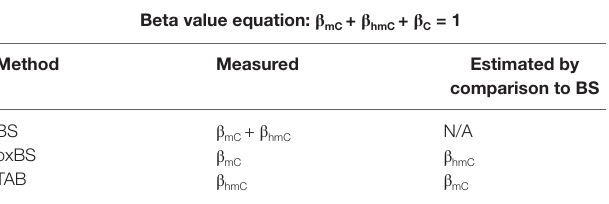
TABLE 1 | Beta value estimation for each described method for measuring base- pair resolution